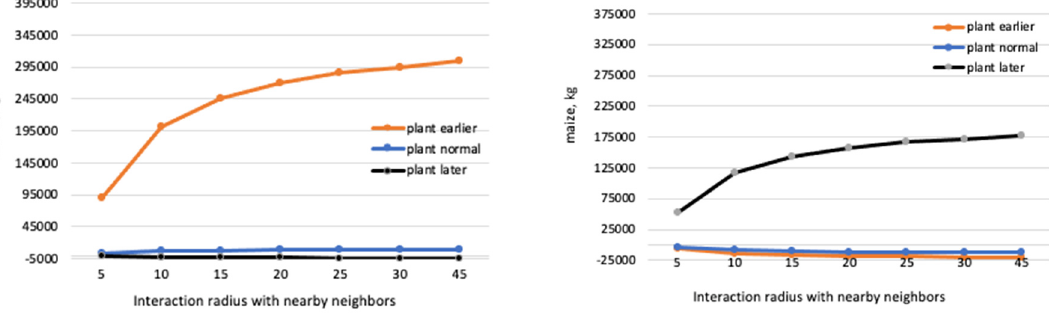
Figure 7. Farmers’ interactions with nearby neighbor farmers with predetermined radius of inter- action .